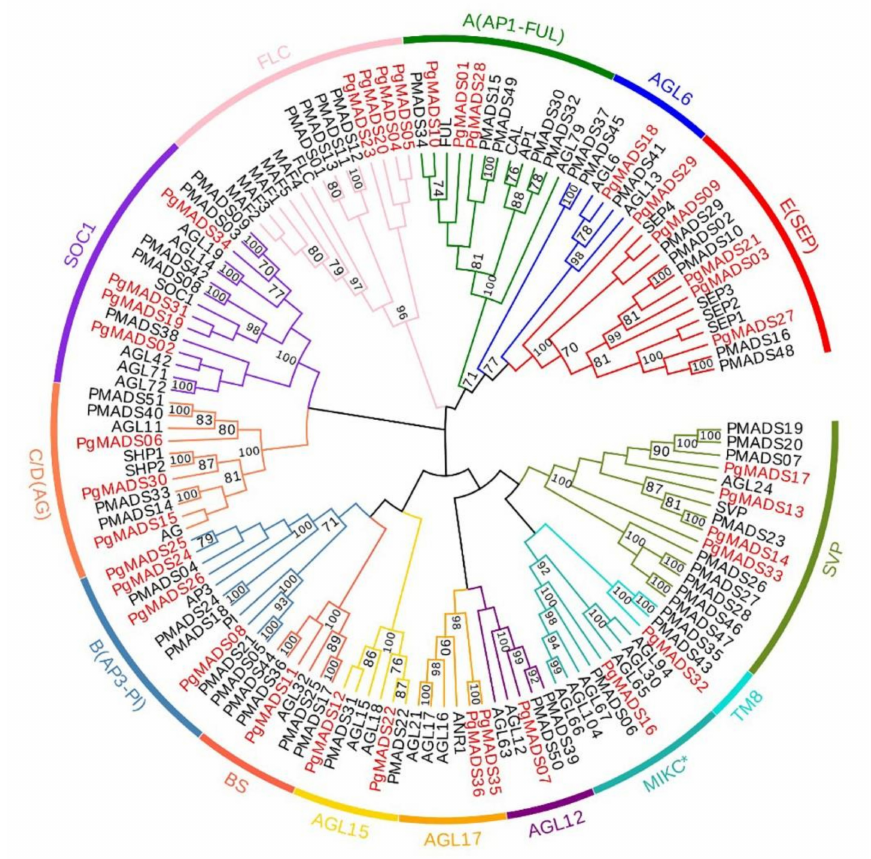
Figure 1. Phylogenetic tree of the MIKC-type MADS-box gene family in pomegranate ( PgMADS ), poplar (PMADS) and